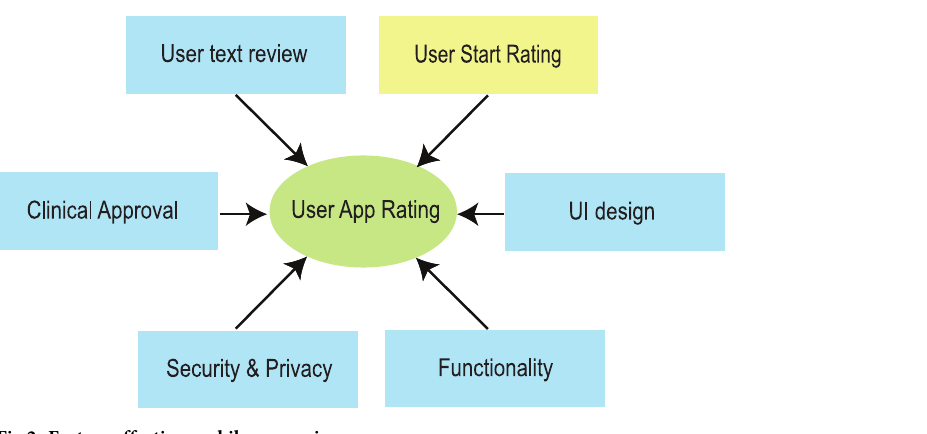
Fig 2. Factors affecting mobile app